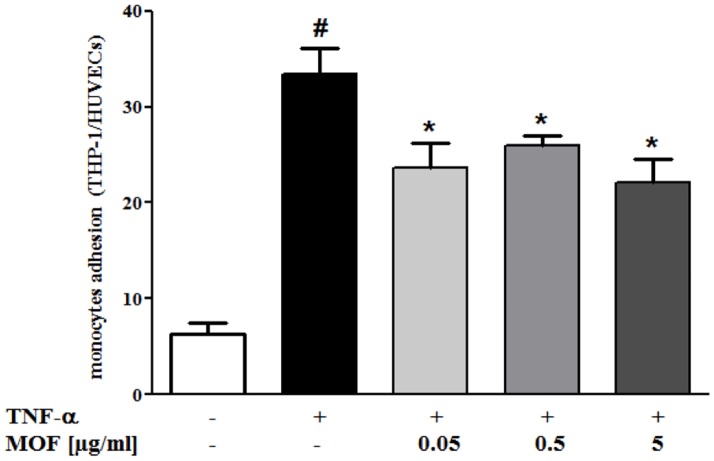
Effect of incubation of THP1 monocytes with MOF concentrations ranging from 0.05–5 µg/ml on adhesion to human umbilical vein endothelial cells (HUVEC).Monocyte adhesion is presented as a ratio of THP1 to HUVEC. Values are means of three independent experiments, with standard deviations represented by vertical bars. Data were analysed using two-way analysis of variance (ANOVA) and significant differences were identified using Tukey's multiple comparisons post-hoc test. Statistical significant difference was set to P<0.05 for all analyses, where * indicating significant different to TNF-α and # indicating significant different to negative control.